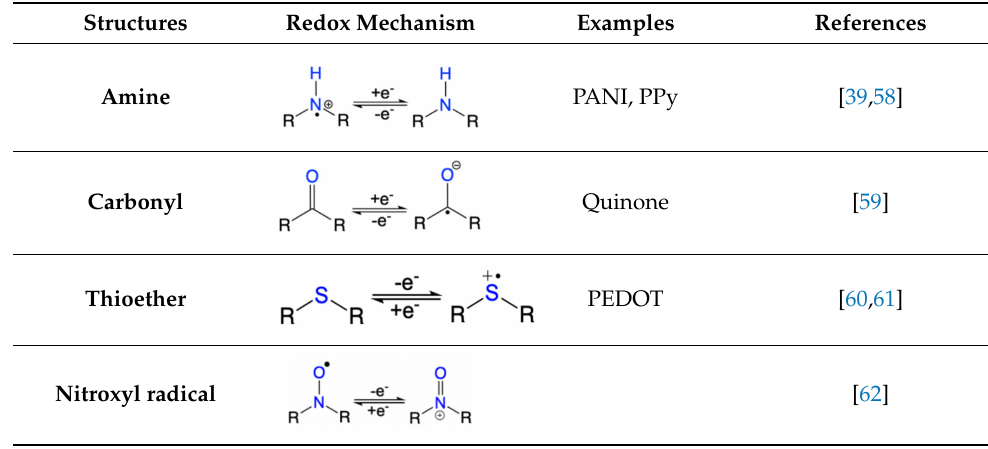
Figure 3. General oxidation and reduction mechanisms for conducting polymers, using PPy as example [30]. Table 1. The redox center of in common electrochemically active organic